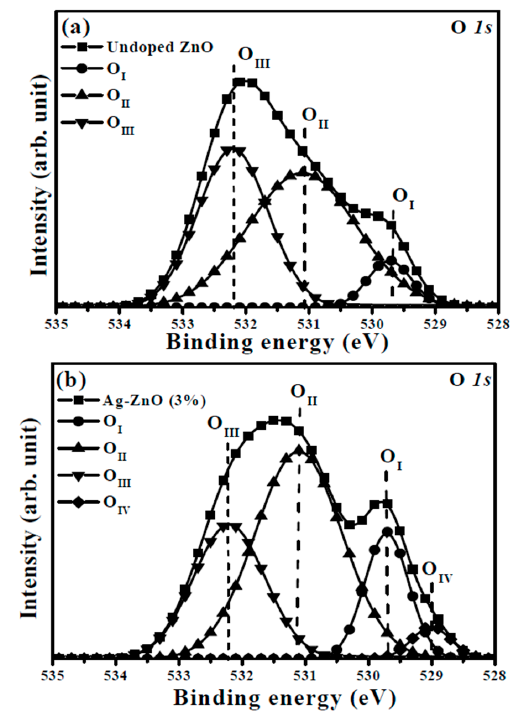
Figure 7. Core level of the O 1s spectra for the ( a ) undoped ZnO film and ( b ) Ag-ZnO co-sputtered film at a theoretical atomic ratio of 3% after annealing at 350 °C for 1 h under ambient air.